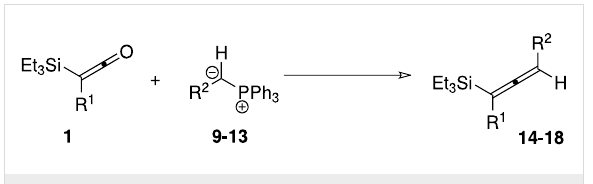
reaction temperatures and times, entries 1, 3 and 5